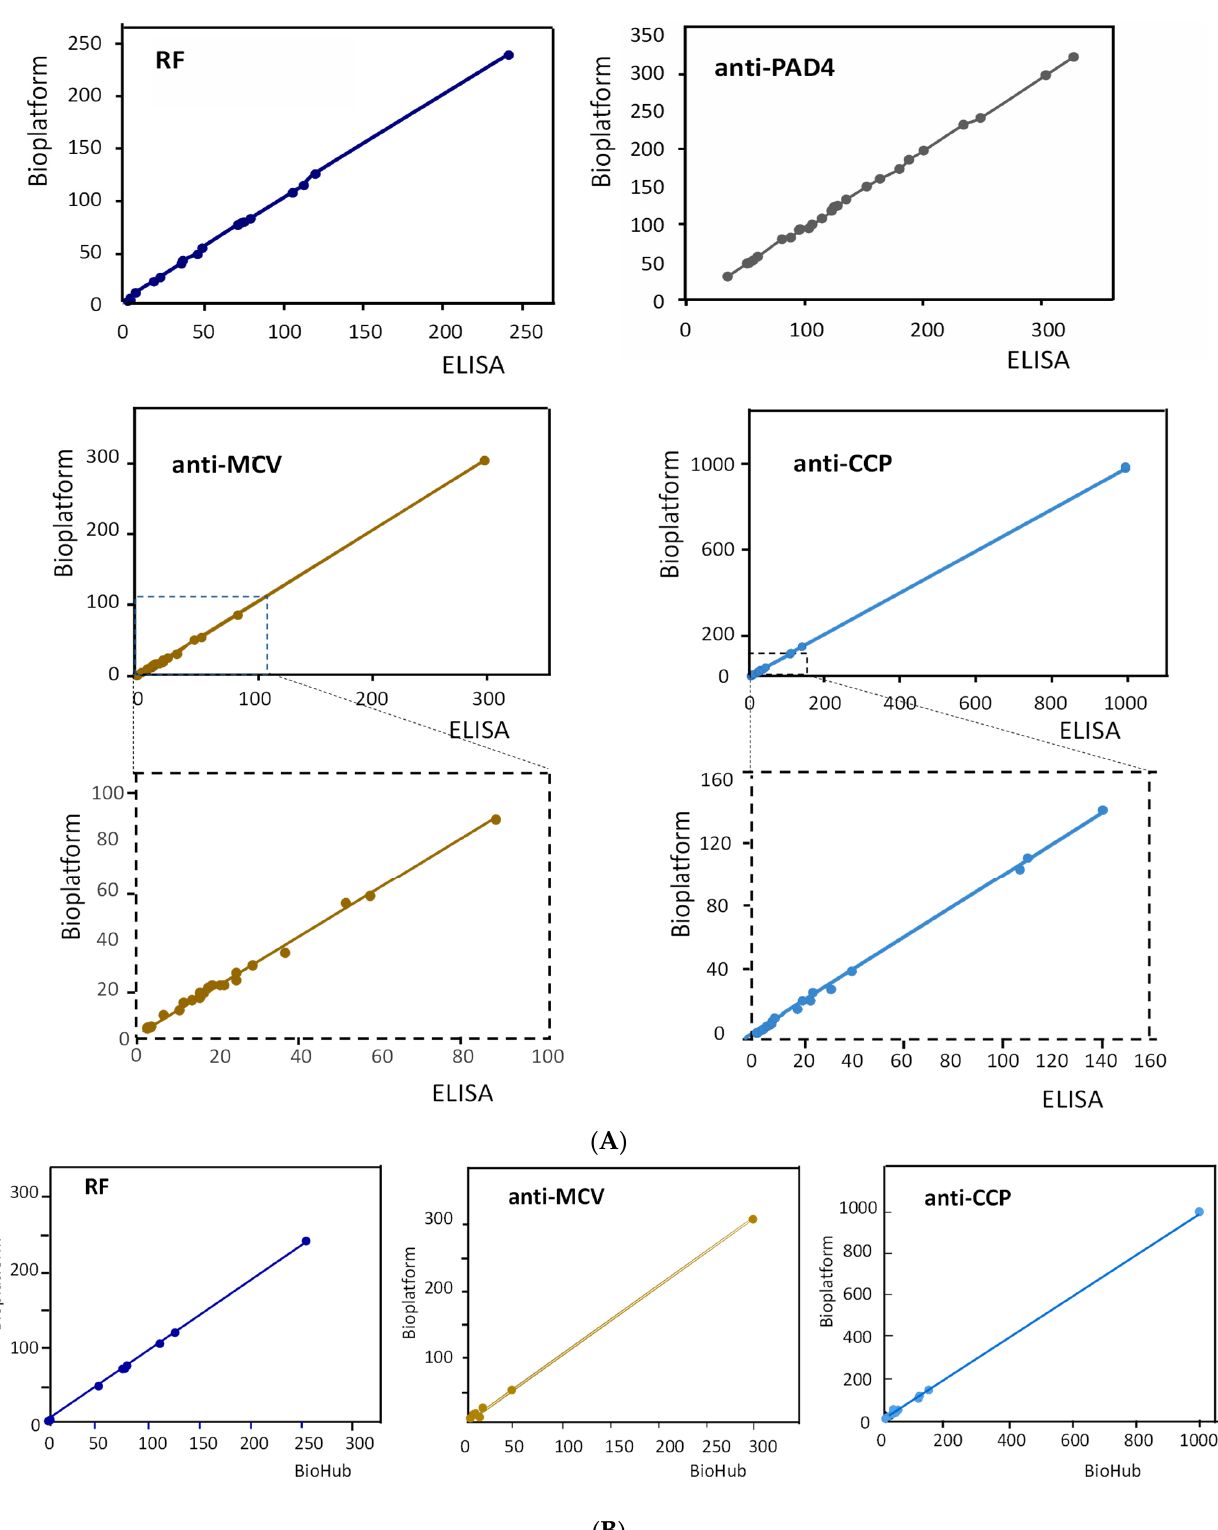
Figure 4. Correlation graphs of the results obtained for the determination of the target autoantibodies with the bioplatform and the individual ELISA kits ( A ) and the contents certified by Bio Hub ® ( B ).